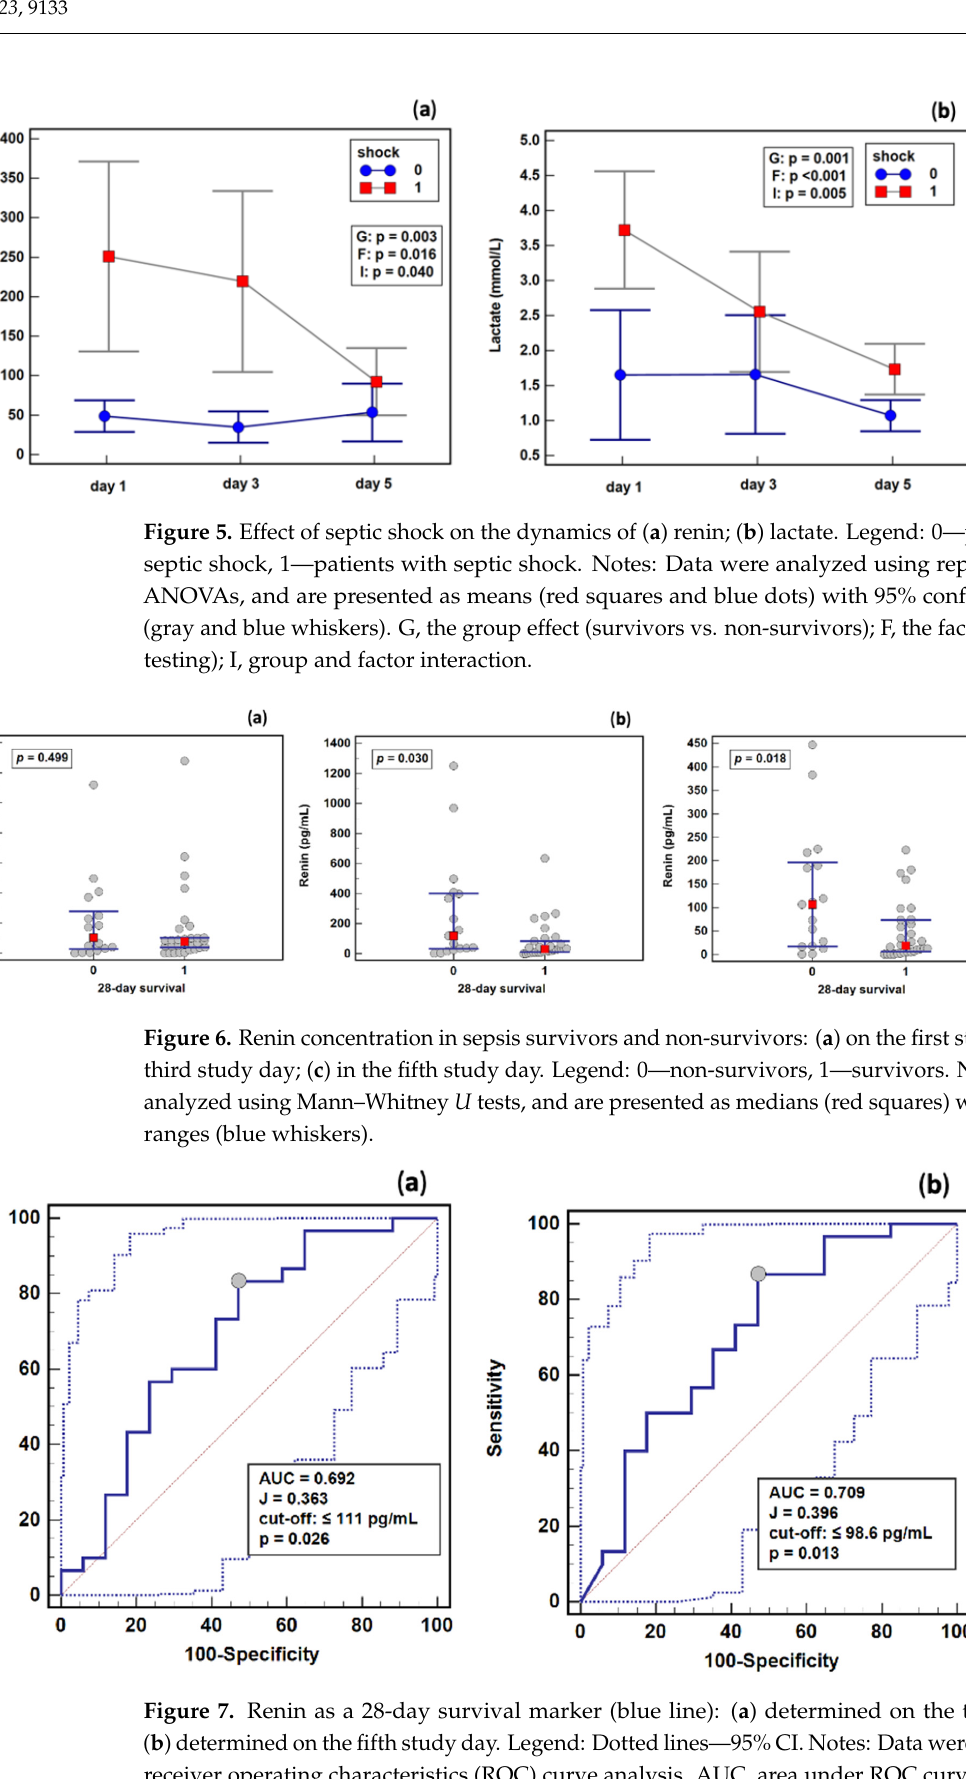
Figure 8. The Kaplan–Meier survival curves for septic patients stratified based on renin concentra- tion: ( a ) assessed on the third day; ( b ) assessed on the fifth day. 2.8. Renin Dynamics in Sepsis Survivors and Non-Survivors The changes in renin concentration during follow-up were affected by the patients’ survival. Renin increased between the first and third days in non-survivors, but dropped in survivors. The changes in lactate were comparable between survivors and non-survi- vors (Figure 9).